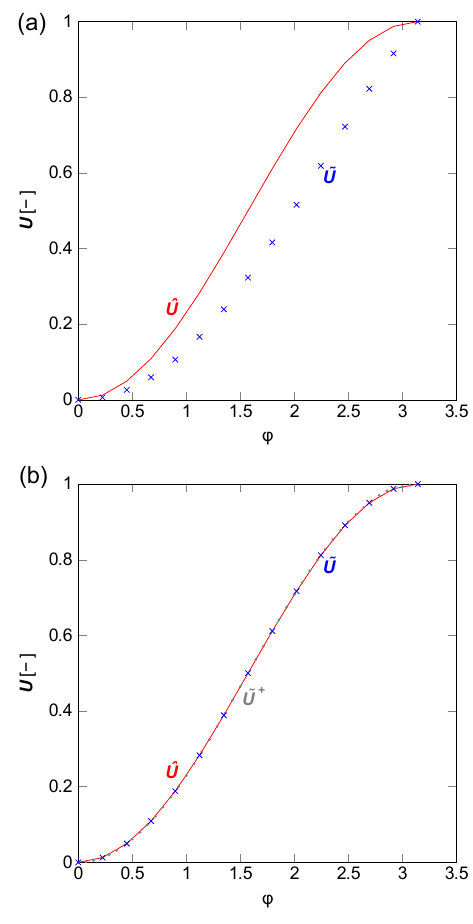
Figure 7. Example 1: target energy-path ˆ U (red line), normalized actual energy-path e U (blue crosses) and normalized actual energy + path at smaller increments e U (grey dots). (a) Initial shape and (b) optimum